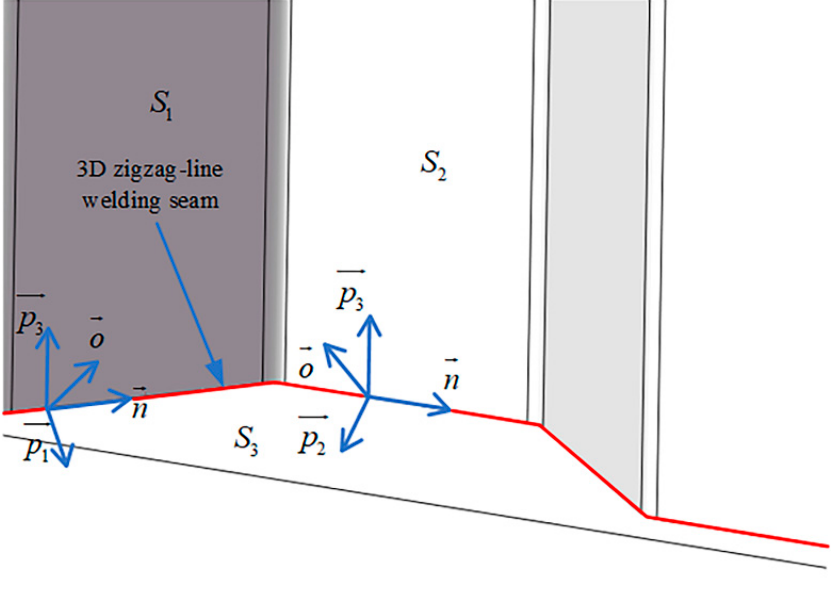
Figure 8. 3D zigzag-line welding seam attitude model.